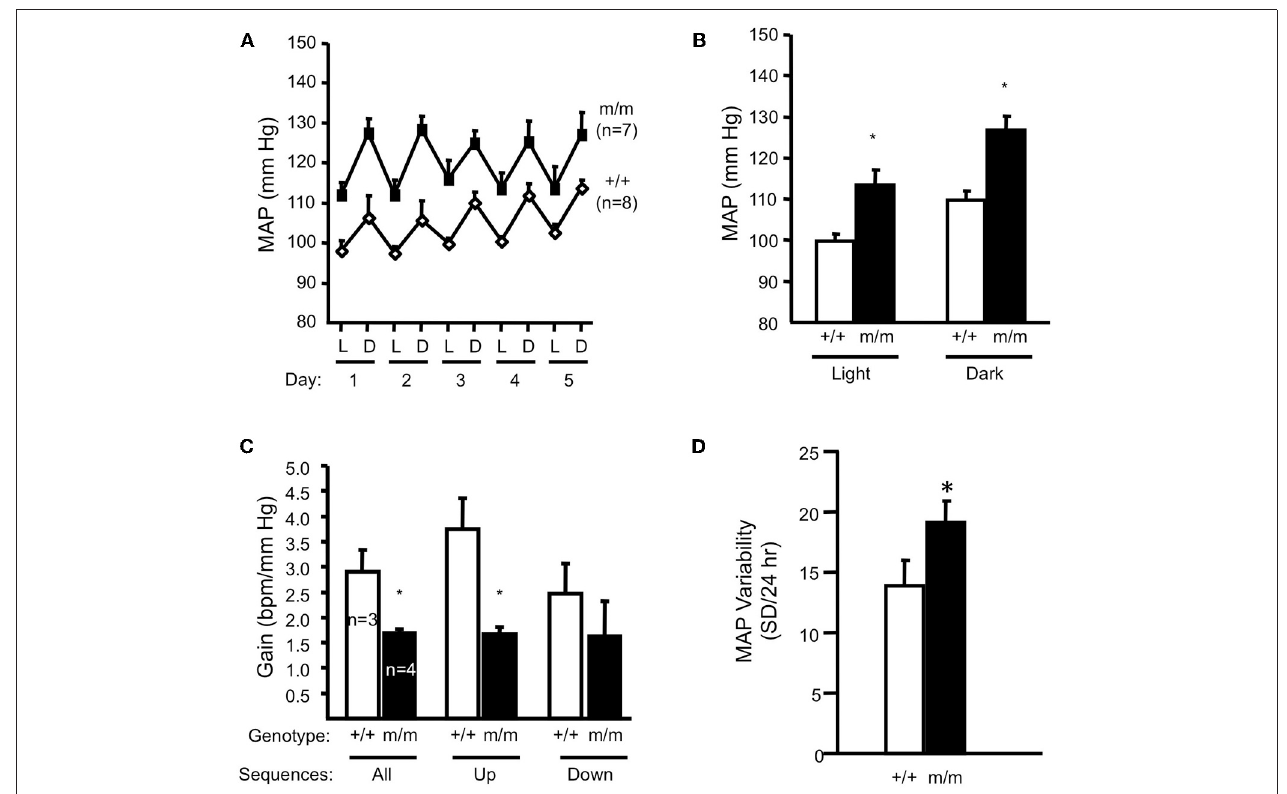
FIGURE 6 | Blood pressure and arterial baroreflex gain in normal salt (0.4% Na + ) fed animals. Mean arterial pressure (MAP) for 12-h light (L)–dark (D) cycles for each of 5 days and the average of 5 days are shown in panels A and B , respectively in wildtype ( + / + , n = 8) and homozygous β ENaC mutant mice (m/m, n = 7). (C) Arterial baroreflex gain is significantly lower in β ENaC m/m mice ( n = 4) vs. + / + controls. (D) Mean arterial blood